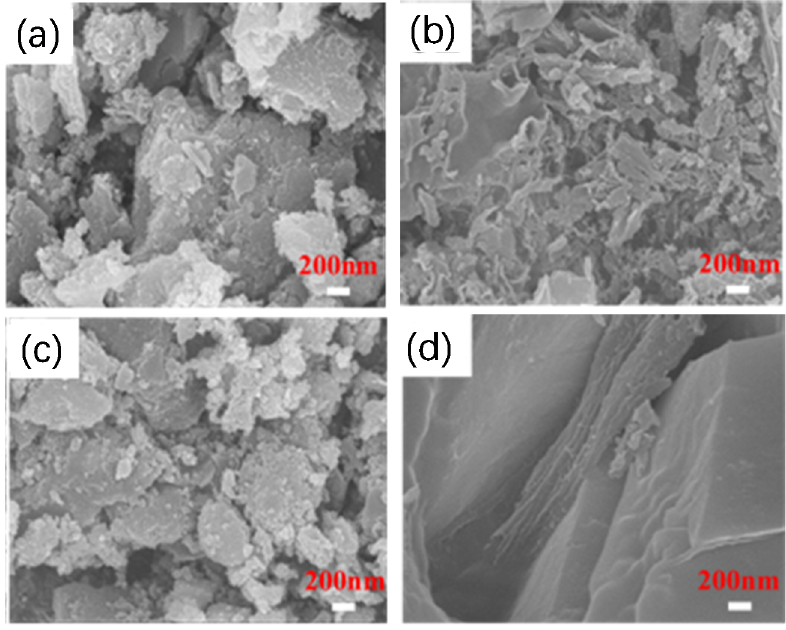
Figure 6. SEM images of ( a ) SrF 2 @C, ( b ) SrF 2 @NC, ( c ) SrF 2 @C-700, and ( d ) SrF 2 @NC-700. The morphology of SrF 2 @C, SrF 2 @NC, SrF 2 @C-700, and SrF 2 @NC-700 was first investigated by SEM (Figure 6). For SrF 2 @C and SrF 2 @NC catalysts, small and sheetlike structure is obtained.